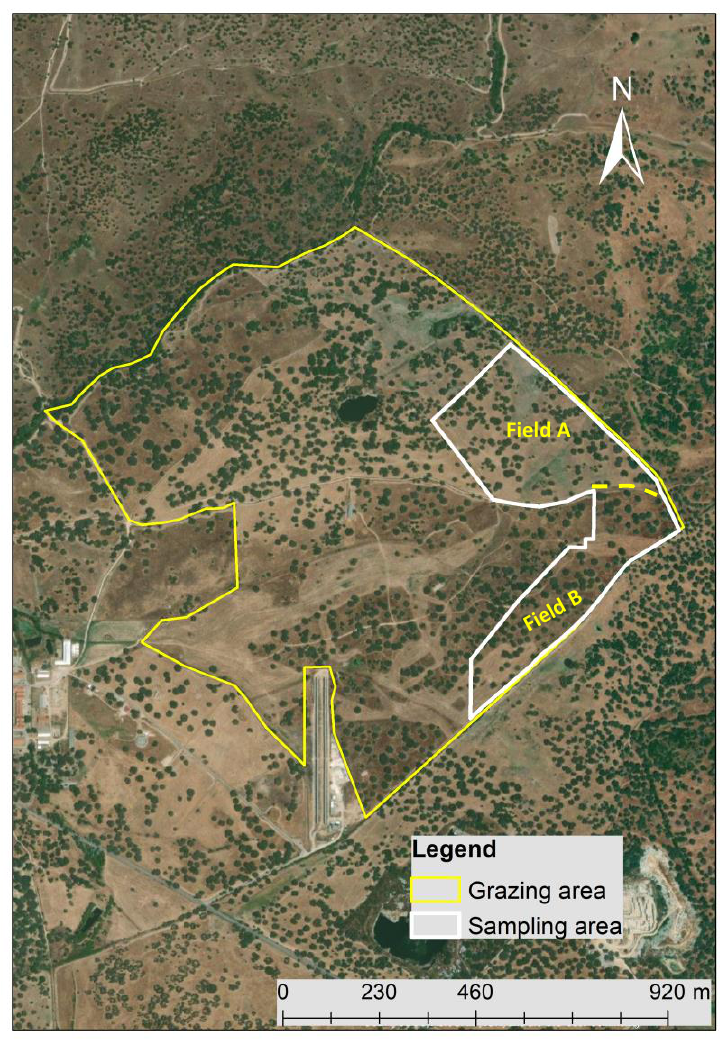
Figure 1. Grazing area and sampling area of the experimental field.